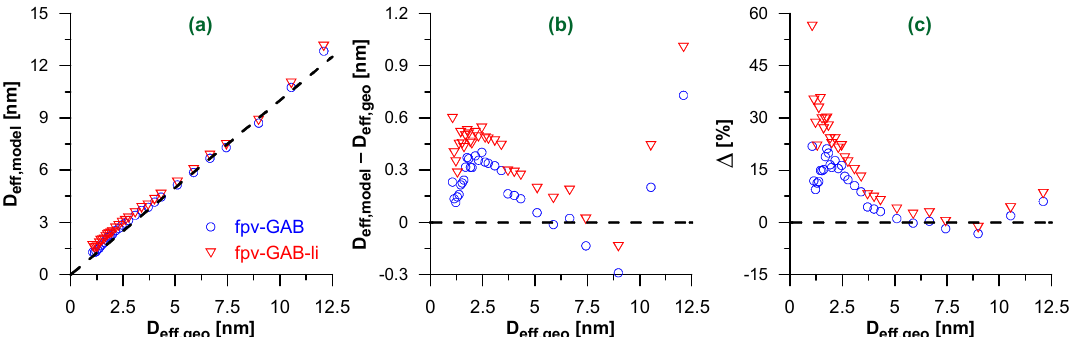
Figure 3. ( a ) Effective pore diameters D eff , model calculated using Equation (2) and fpv-GAB (blue circles) or fpv-GAB-li (red triangles) fits of simulated isotherms of N 2 adsorption in CNTs. The diameters are plotted as the function of the geometrical diameter of CNTs ( D eff , geo ). The dashed line represents D eff , model = D eff , geo ; ( b , c ) the absolute ( b ) and relative ( c ) differences between D eff , model and D eff , geo . The horizontal dashed lines correspond to D eff , model = D eff , geo